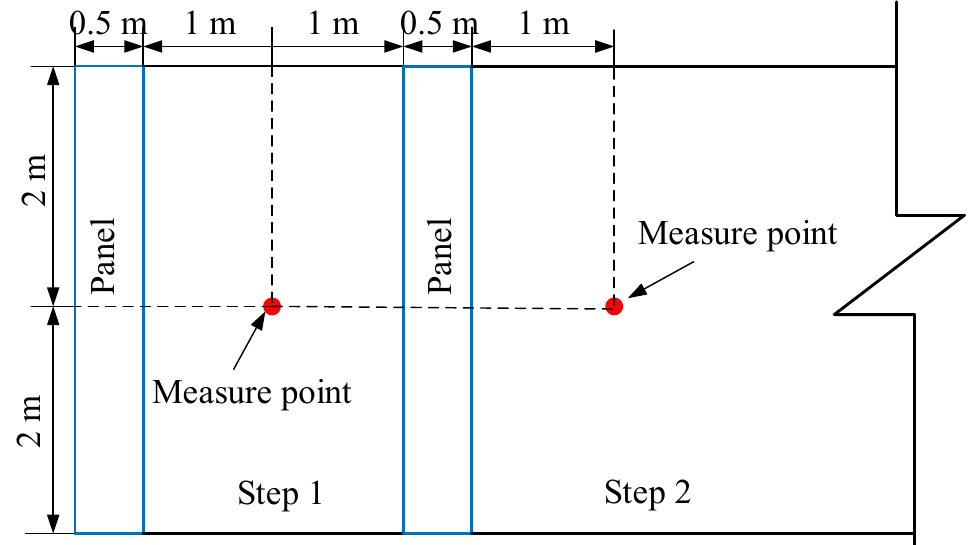
Figure 12. Top view of measuring point distribution.